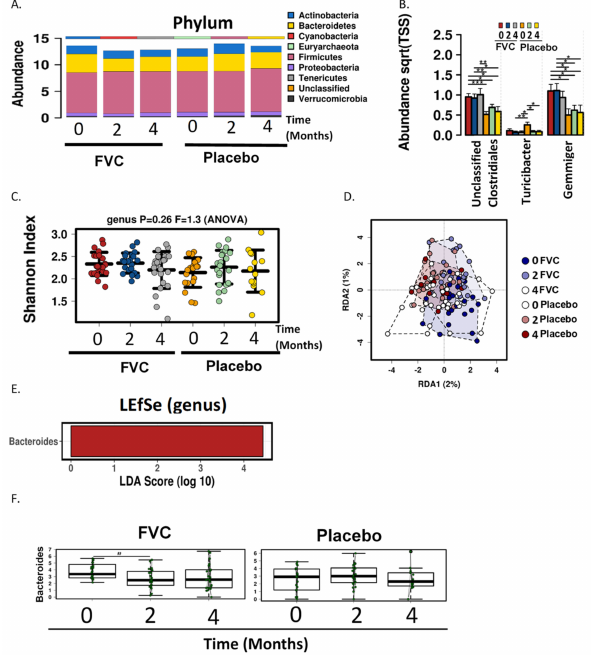
Figure 2. Microbiome abundance and diversity with FVC supplementation. ( A ) Fecal microbiota taxonomic abundance (phylum level) and ( B ) bar charts of abundance for the genera unclassified Clostridiales, Turicibacter and Gemminger for the FVC and placebo groups at baseline (0) and 2 and 4 months. No significant changes were observed at phylum level, but genus level difference existed between groups. * p ≤ 0.05, ** p ≤ 0.01, *** p ≤ 0.001. ANOVA. ( C ) Scatterplot showing differences in α -diversity at genus level determined by Shannon index of the fecal microbiome at baseline and months 2 and 4 for the FVC vs. placebo groups. No differences were detected. ( D ) Redundancy analysis (RDA) plot demonstrating β -diversity of the fecal microbiome at baseline and months 2 and 4 for FVC vs. placebo. No significant differences were detected. ( E ). Linear discriminant analysis (LDA) effects size (LEfSe) analysis shows differentially abundant genera with an LDA score > 4 within the FVC group. ( F ) Box plots showing levels of Bacteroides for FVC and placebo groups at baseline, month 2 and 4. # p = 0.08, Mixed linear regression. (N = 27, FVC; N = 30, placebo) FVC, dried fruit and vegetable supplement.